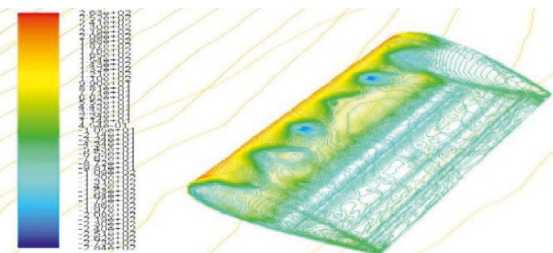
Figure 10: Total pressure at 15 ° AOA for the 1st module.